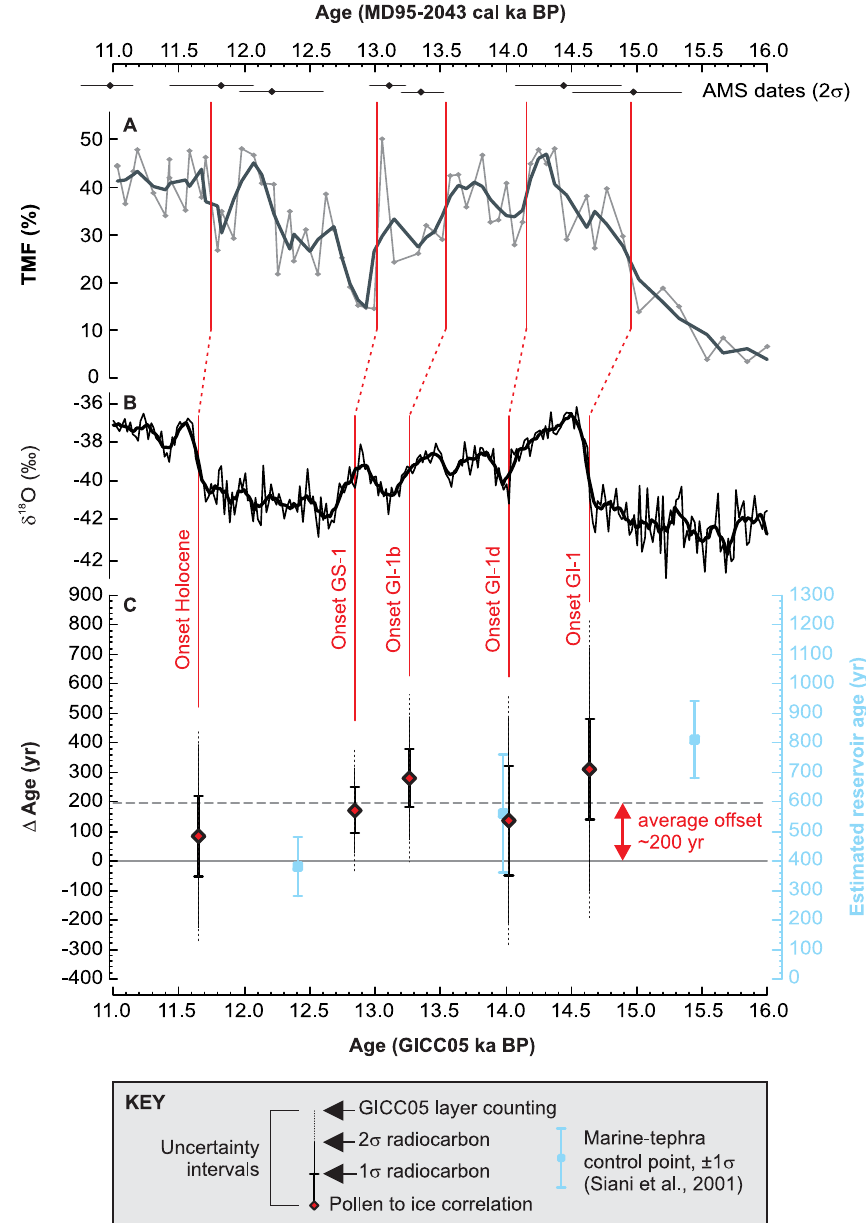
Fig. 7. Comparison of MD95-2043 radiocarbon and ice-core (GICC05) age estimates for five Lateglacial climatic transitions, showing: (A) Temperate Mediterranean forest (TMF) pollen curve from core MD95-2043 (raw values and 3-point moving average) plotted on the MD95- 2043 calibrated radiocarbon timescale; (B) NGRIP δ 18 O values on the GICC05 timescale with 100-yr moving average (NGRIP members, 2004; Rasmussen et al., 2006); (C) Difference between calibrated radiocarbon age and GICC05 ages ( y -axis) plotted against the GICC05 timescale ( x -axis). Positive values indicate older ages on the MD95-2043 radiocarbon timescale. Vertical error bars show uncertainty estimates in the radiocarbon age model, and ice-layer counting in the GICC05 timescale as published in Rasmussen et al. (2006). Surface water age estimates for the Adriatic from Siani et al.